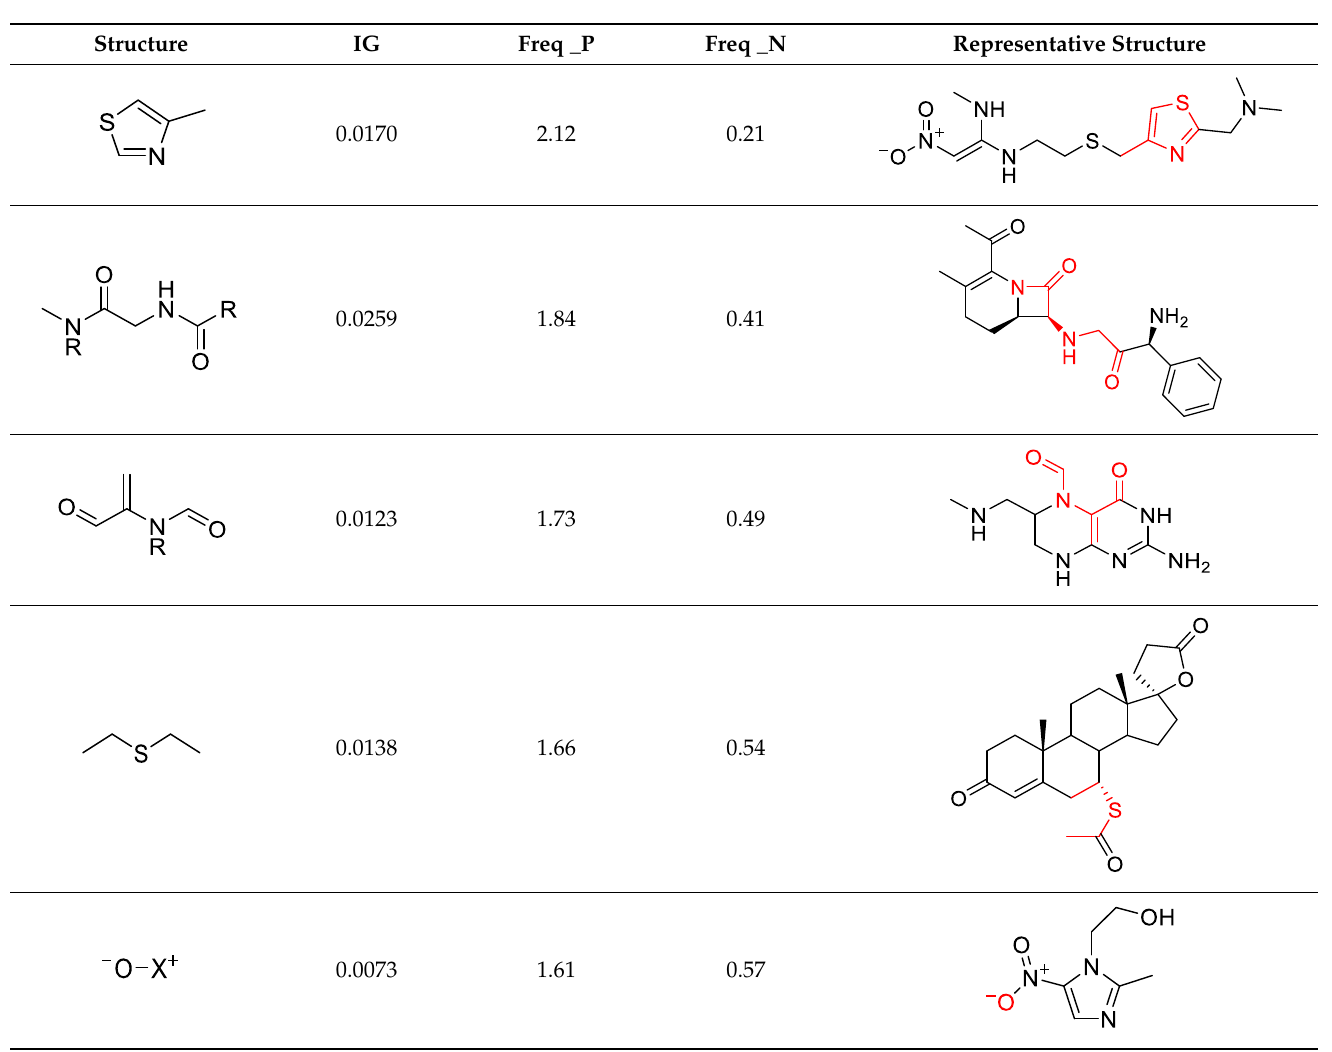
Table 6. Five structural alerts of DITP toxicity and their representative structures.